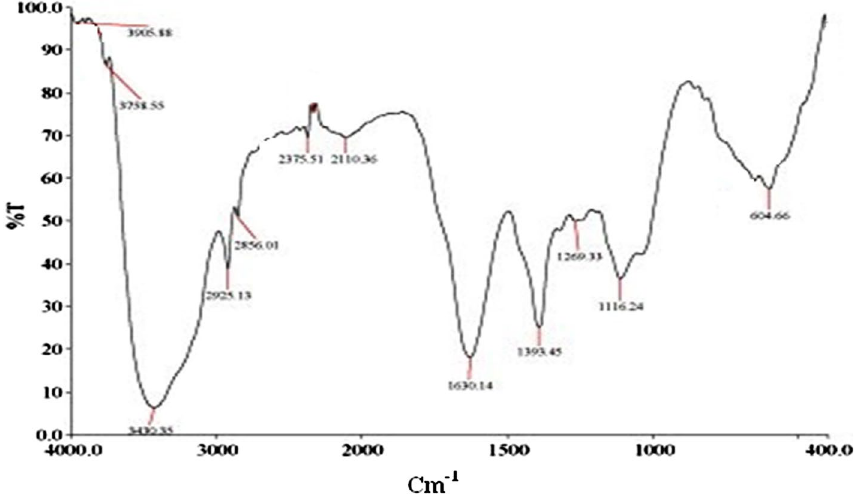
Fig. 3 FTIR spectrum of banana peel dust